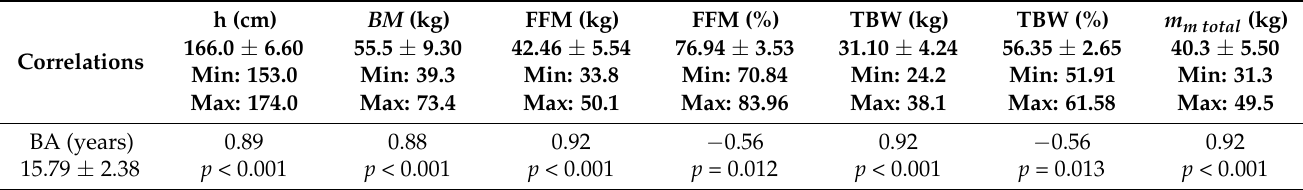
Table 2. Correlations of anthropometric, body composition indices: BA , h , BM , m m total , m m arms , m m trunk , and m m legs with tethered swimming indices: F max , F ave , I ave , and F decline